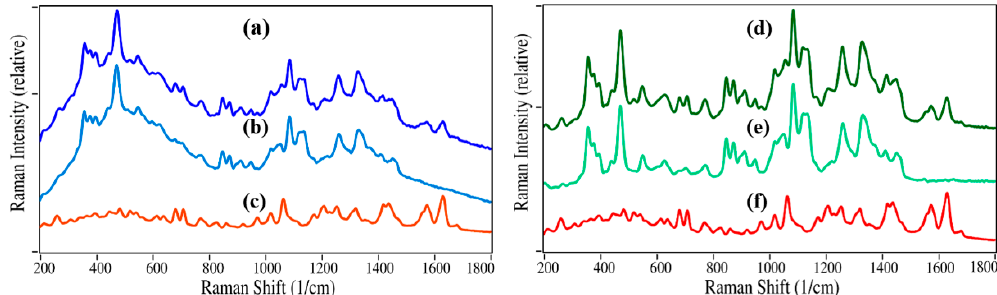
Figure 5. Raman spectra of ( a ) Claritin (30 tablet average), ( b ) the excipient created by subtracting ( c ) loratadine from ( a ), ( d ) a generic for Claritin (30 tablet average), ( e ) the excipient created by subtracting ( f ) loratadine from ( d ). Spectral Conditions: 275 mW at 1064 nm, 10 averaged, 2-s integration scans. Spectra are offset for clarity. Intensities are the same scale, except loratadine spectra ( c ) and ( f ), which were increased by a factor of 2.